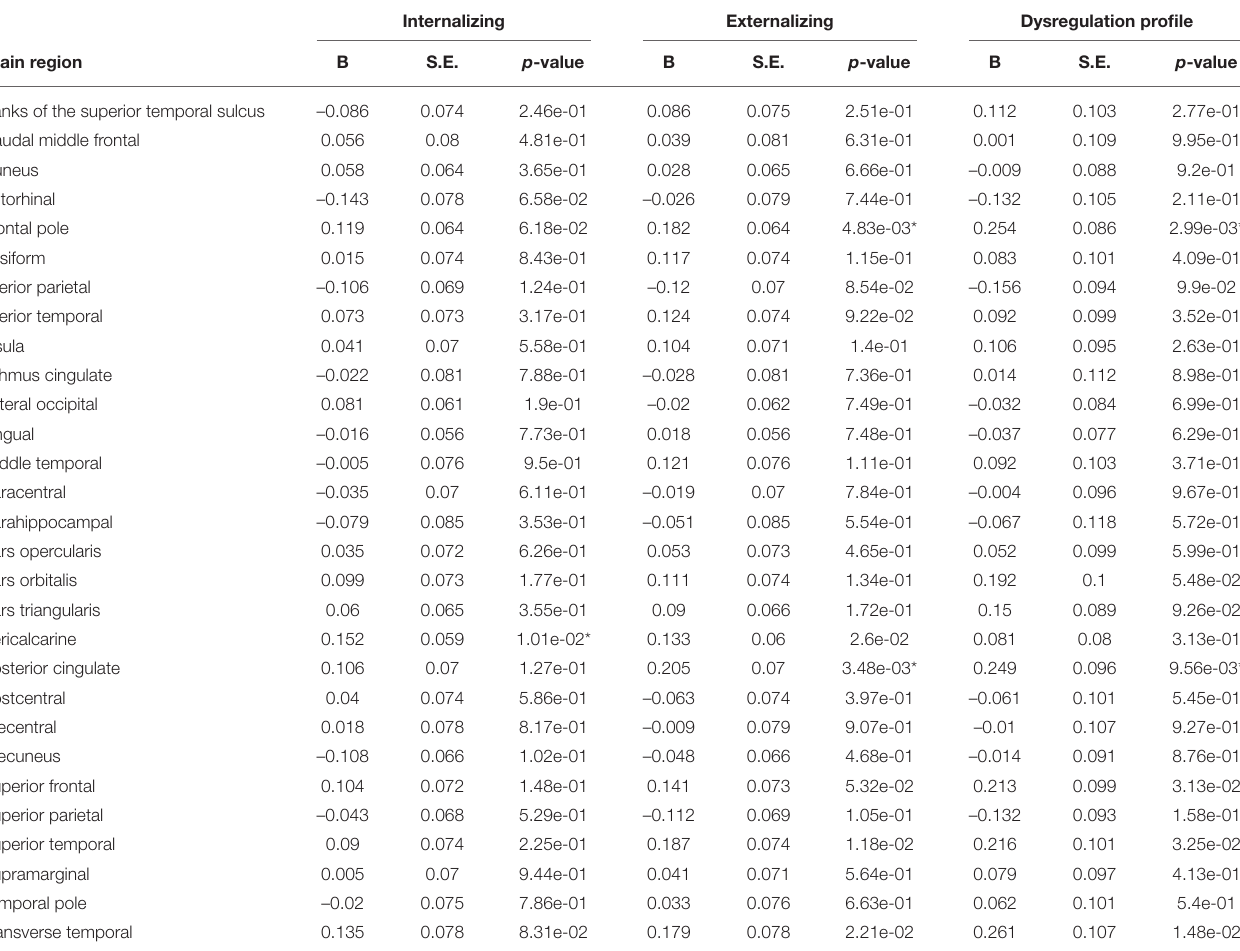
TABLE 5 | Exploratory cortical thickness model